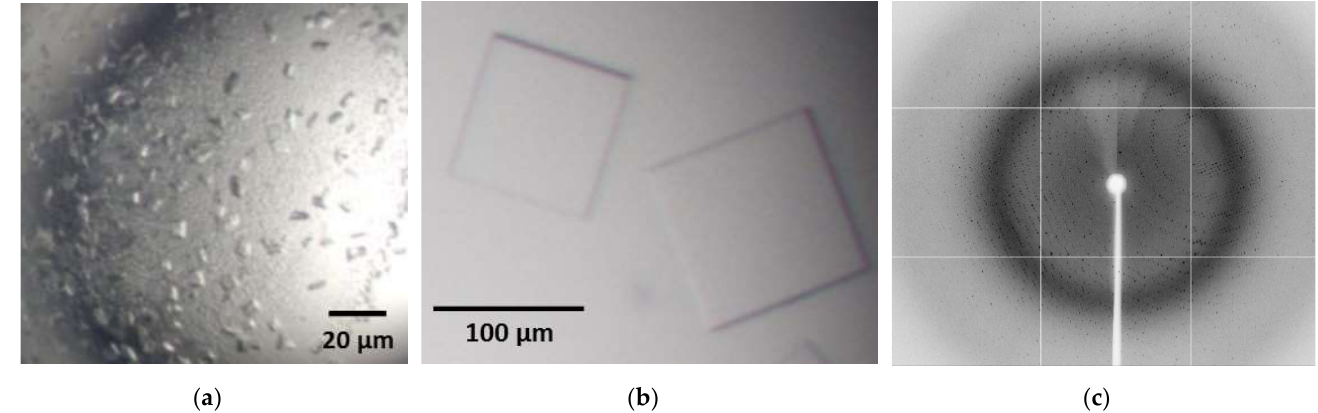
Figure 5. NA crystallization and X-ray diffraction. ( a ) Crystals in a hit condition containing 0.1 MES monohydrate pH 6.5, 12% w/v PEG-20,000. ( b ) Flat square plates (~100 µm × 100 µm × 5 µm) resulted from optimisation of hit condition. ( c ) X-ray diffraction image produced by produced by a H1N1 NA crystal collected at the MX2 beamline at the Melbourne Synchrotron. Maximum resolution of 2.04 Å at the edge of the detector, beam energy 12,664.9 eV, detector distance 300 mm, exposure time 1 s. A larger version of this diffraction image can be found in Figure S1.